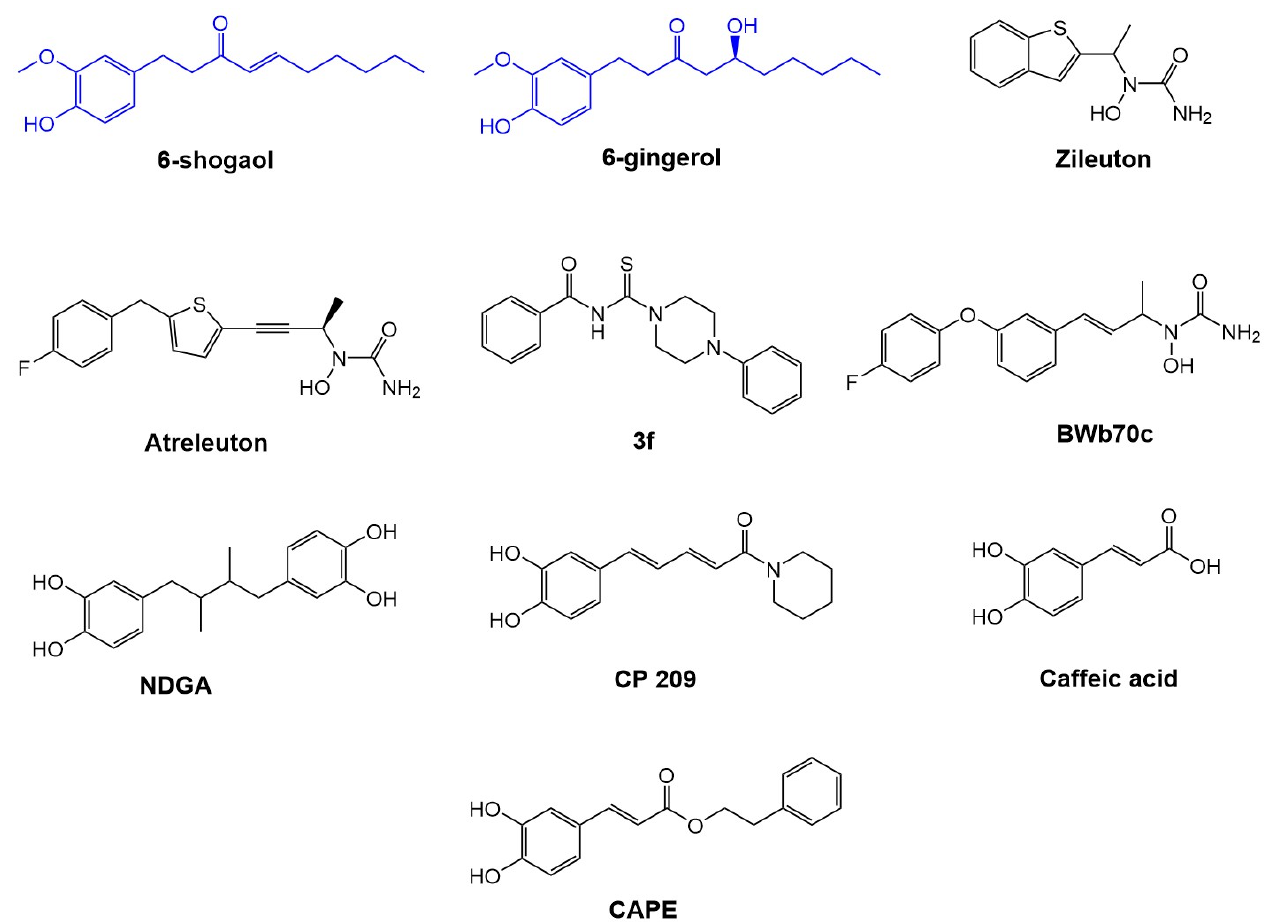
Figure 1. Chemical structures of main redox inhibitors of 5-LOX. Chemical structures of 6-gingerol, 6-shogaol, commercial redox inhibitors (zileuton and atreleuton) of 5-LOX, and candidate inhibitors of 5-LOX.